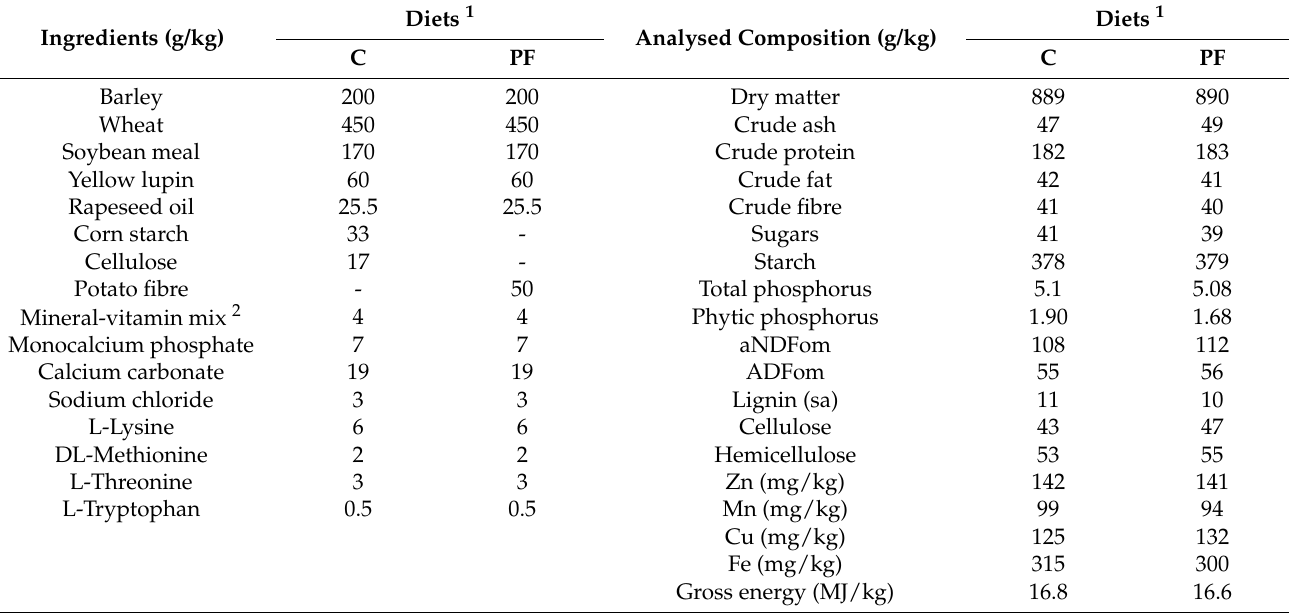
Table 1. Ingredients and chemical composition of the cereal-based